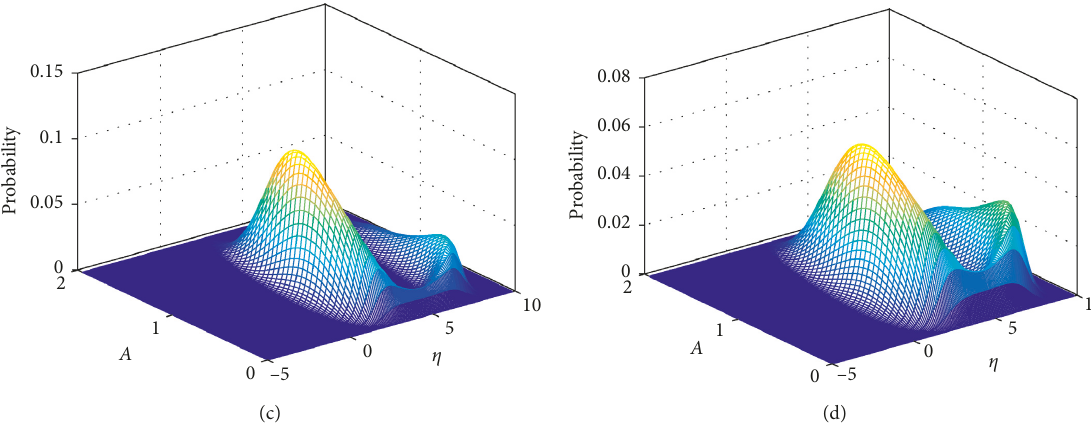
Figure 13: Joint probability of the multistable energy harvester: (a) c � 0 . 1; (b) c � 0 . 2; (c) c � 0 . 3; (d) c � 0 . 4.